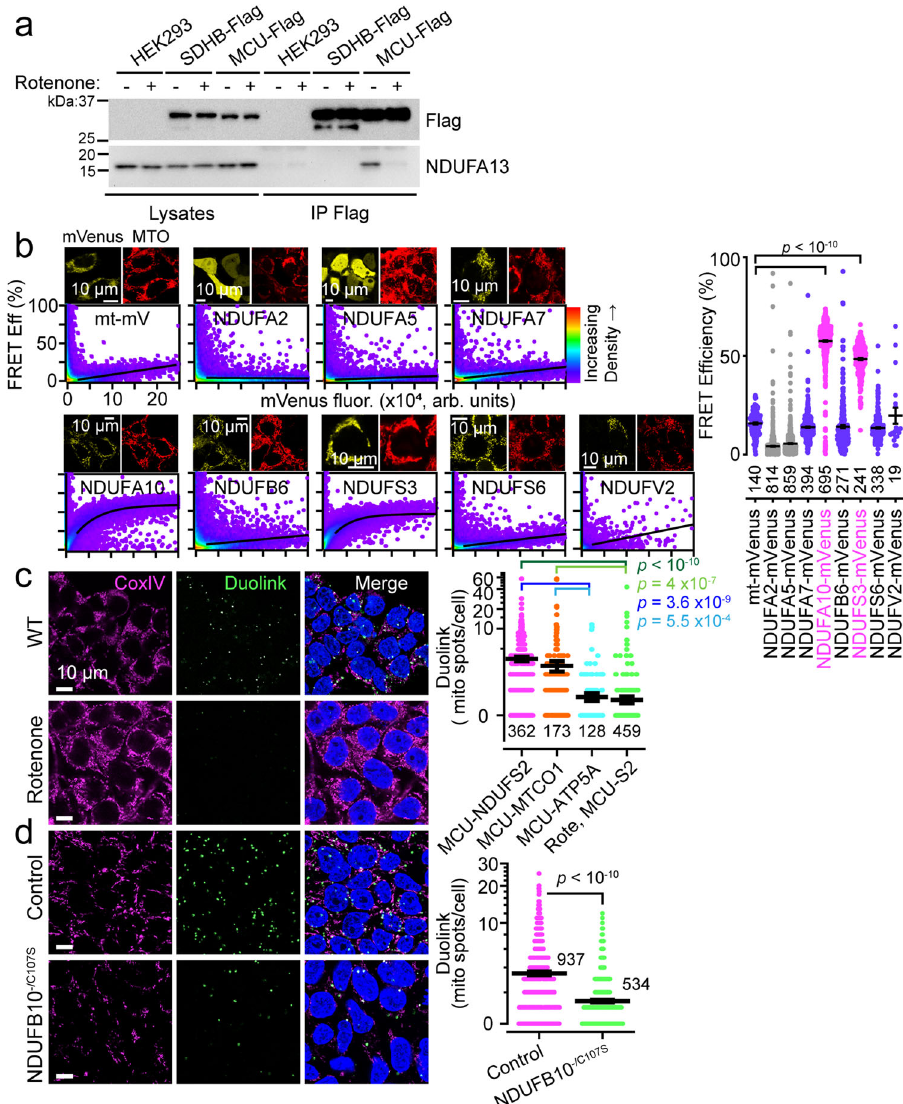
Fig. 3 A direct interaction between MCU and Complex I alters uniporter stability. a NDUFA13 co-immunoprecipitates with MCU-Flag. Images are representative of 3 separate trials. b Left, mVenus-tagged Complex I subunits surveyed for FRET with MCU-mCerulean via fl ow cytometry. Images above each graph show mVenus-tagged constructs and MitoTracker Orange (MTO). Within graphs, each point in the density plot is an individual cell expressing MCU-mCerulean and the corresponding mVenus-tagged construct. For each cell, the FRET ef fi ciency between its mCerulean and mVenus is displayed in the y axis, while the degree of expression of the mVenus-tagged construct is revealed by the mVenus fl uorescence in the x axis. Right, summary of FRET ef fi ciency between MCU-mCerulean and the corresponding mVenus-tagged constructs at moderate mVenus expression. c Left, MCU-NDUFS2 Duolink colocalization occurs in mitochondria (CoxIV) and is more prevalent at baseline (WT) than after Complex I inhibition (Rotenone). Right, Duolink summary. Note that 74% of MCU-ATP5A and 85% of Rotenone-treated (MCU-S2) cells had zero Duolink spots, compared to 27% of MCU-NDUFS2 and 37% of MCU-MTCO1 cells. d Left, MCU-NDUFS2 Duolink greater in control than NDUFB10 − /C107S IPSCs. Right, Summary. 45% of NDUFB10 − /C107S IPSCs had zero Duolink spots, compared to 19% for control. Summary data are presented as mean values ± SEM. Statistics: ( b , c ) 1-way ANOVA followed